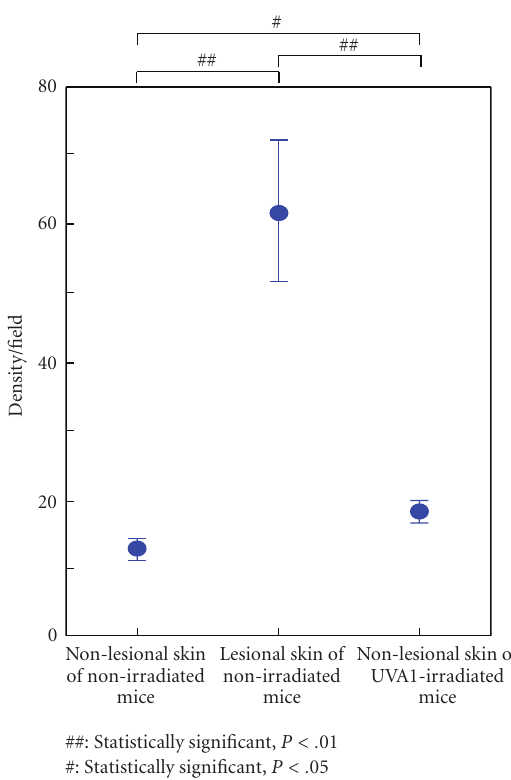
Figure 4: Density of dermal infiltrating mast cells in the skin of MRL/lpr mice. In the LE-like skin lesions of MRL/lpr mice, the density of dermal infiltrating mast cells was the highest as compared with the nonlesional skin of the other mice ( P < . 01). Furthermore, in the nonlesional skins, there was a significant di ff erence between UVA1-irradiated (10J/cm 2 ) and nonirradiated mice ( P < . 05). There was no significant di ff erence between UVA1 5 and 10J/cm 2 groups. The data represent means ± 1 SD from 5 samples of each